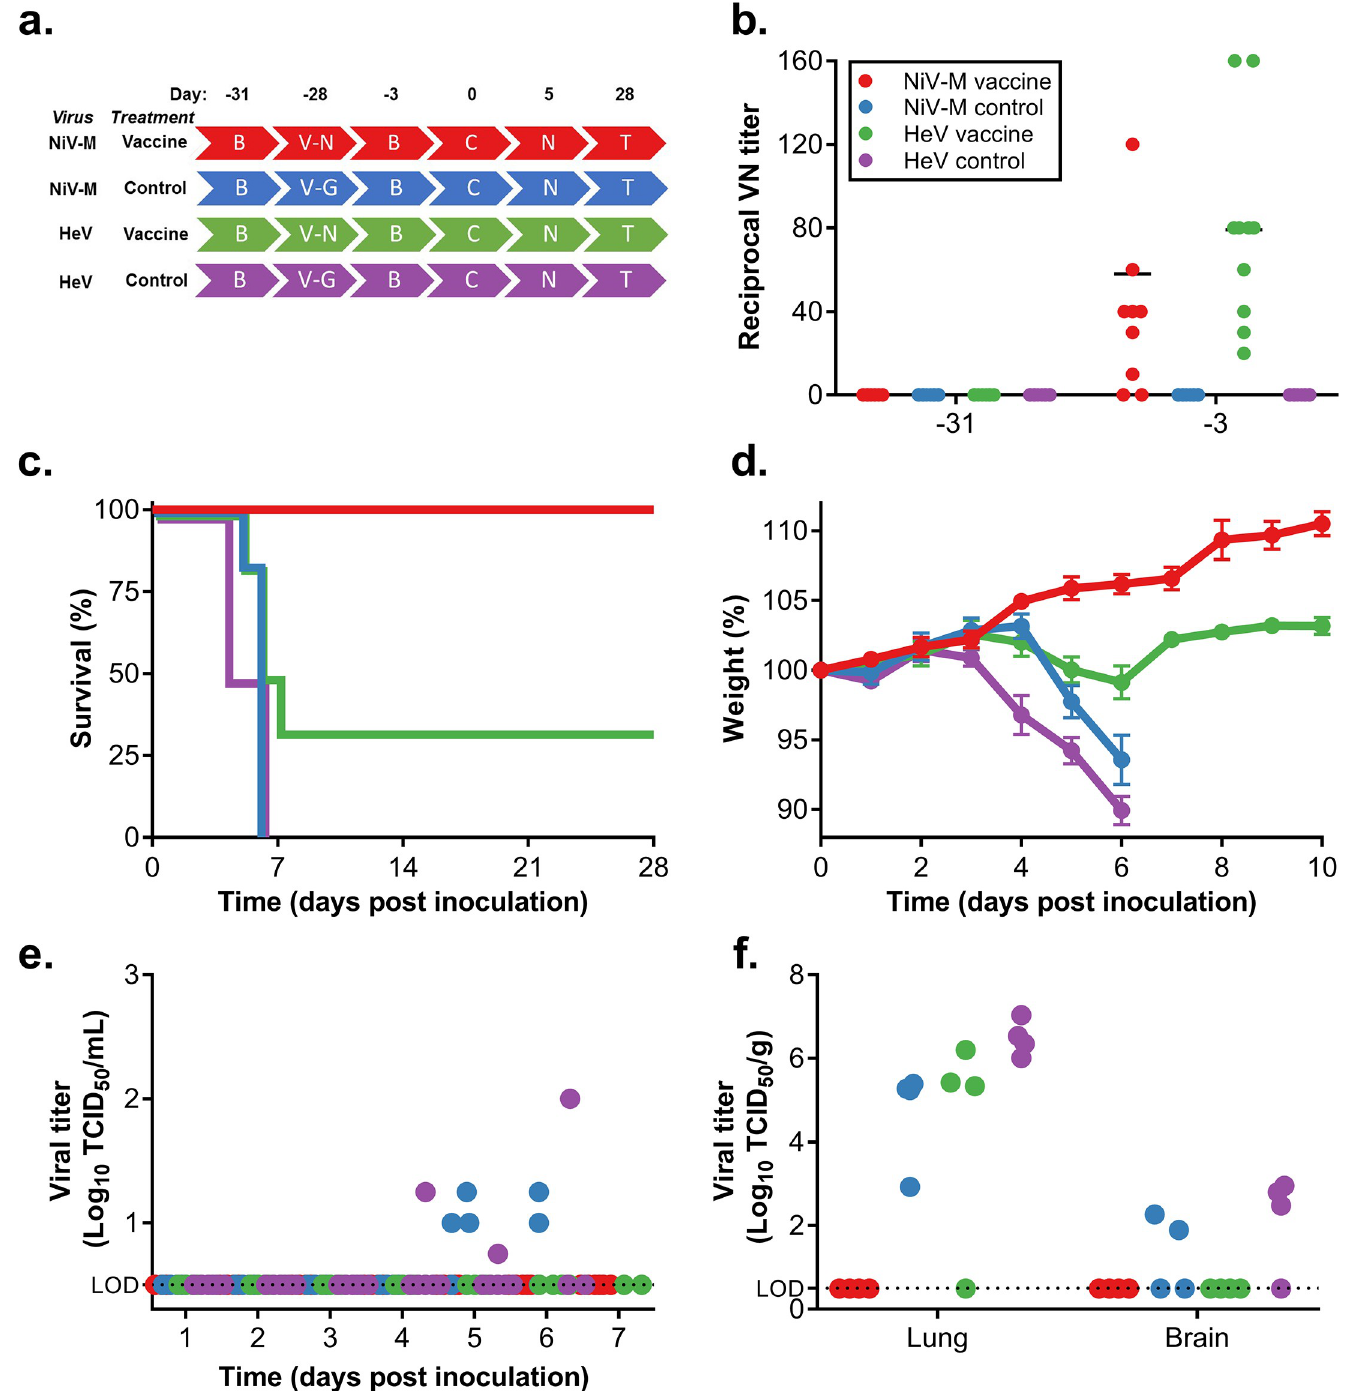
Fig 3. Single-dose vaccination with ChAdOx1 NiV B protects Syrian hamsters against a lethal challenge with NiV Malaysia, but not HeV. (a) Experimental layout. B = bleed; V-N = ChAdOx1 NiV B vaccination; V-G = ChAdOx1 FGP injection; C = challenge; N = necropsy; T = Termination experiment. (b) Neutralizing antibodies in serum were determined via virus neutralization assay on VeroE6 cells at D-31 and D-3. (c) Survival of Syrian hamsters challenged with NiV Malaysia or HeV. (d) Weight loss of challenged animals. (e) Shedding of infectious virus in oropharyngeal swabs collected daily from challenged animals. Virus titers were determined via endpoint titration on VeroE6 cells. (f) Infectious virus titers in lung and brain tissue collected from challenged animals at D4 (HeV) or D5 (NiV). Virus titers were determined via endpoint titration on VeroE6 cells.